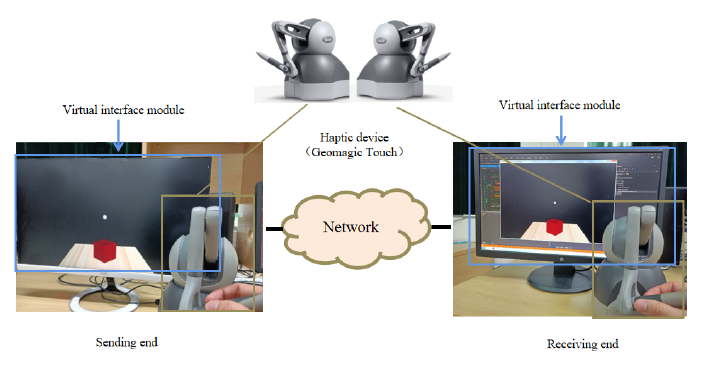
Figure 1. Our simulation platform for haptic–visual signal